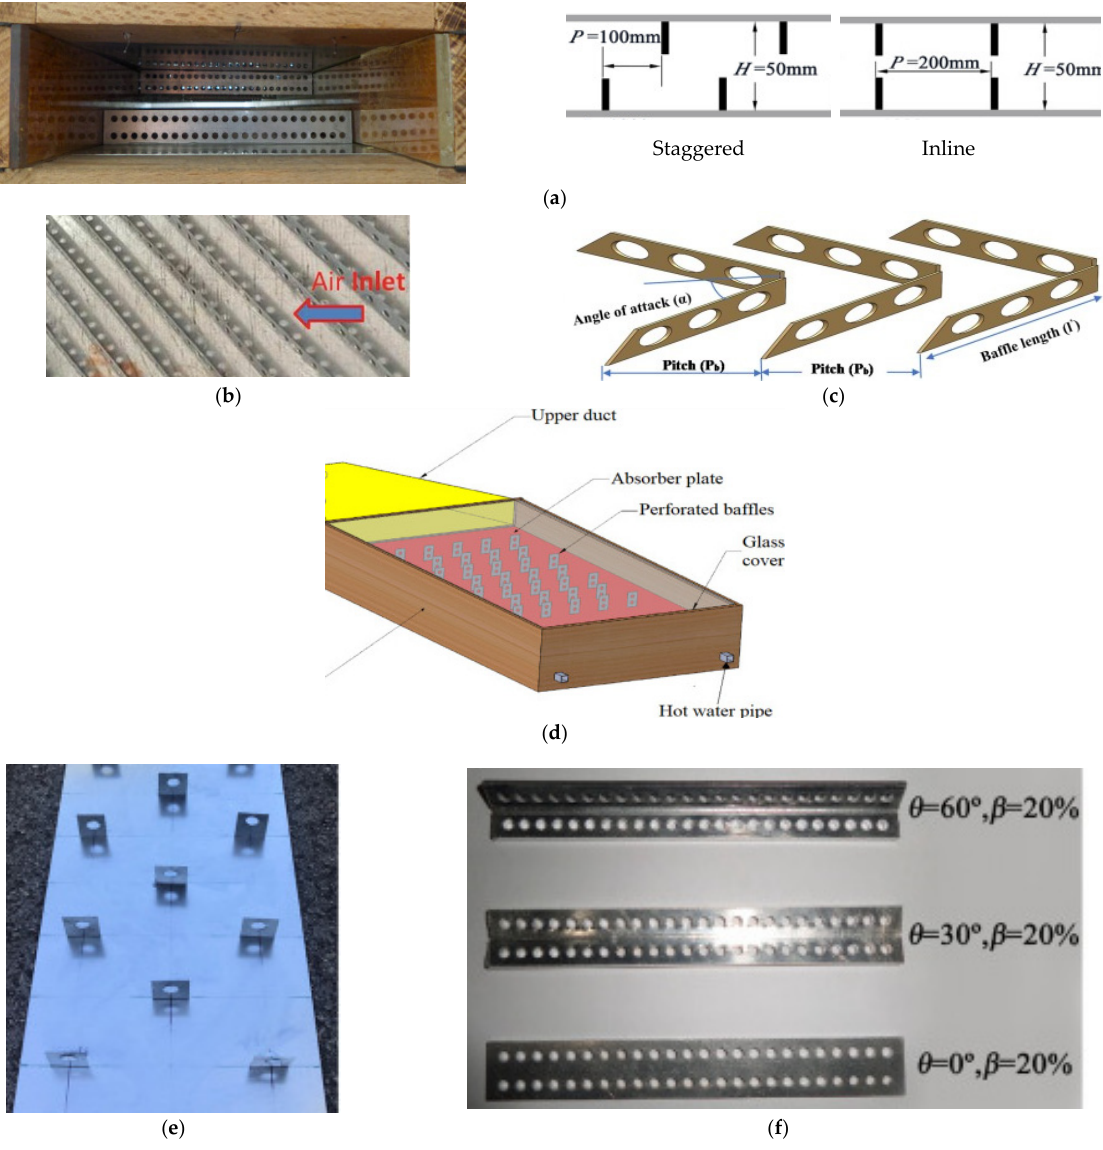
Figure 1. Previously designed perforated baffles. ( a ) Inline/staggered perforated baffles [11]. ( b ) In- clined perforated baffles [10]. ( c ) V-down pattern perforated baffles [14]. ( d ) Perforated baffles [15]. ( e ) Perforated baffles [16]. ( f ) Staggered and partially tilted perforated baffles